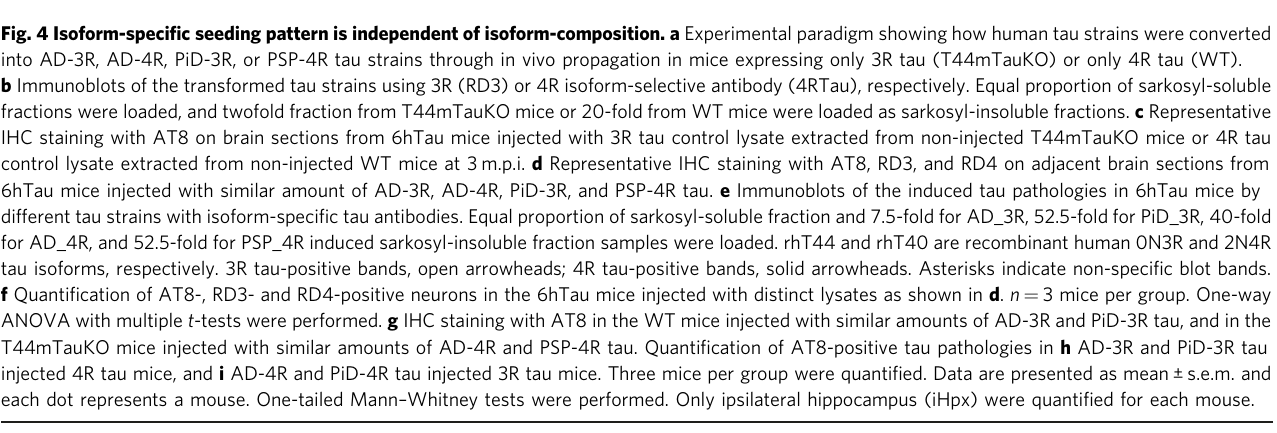
Fig. 4 Isoform-speci fi c seeding pattern is independent of isoform-composition. a Experimental paradigm showing how human tau strains were converted into AD-3R, AD-4R, PiD-3R, or PSP-4R tau strains through in vivo propagation in mice expressing only 3R tau (T44mTauKO) or only 4R tau (WT). b Immunoblots of the transformed tau strains using 3R (RD3) or 4R isoform-selective antibody (4RTau), respectively. Equal proportion of sarkosyl-soluble fractions were loaded, and twofold fraction from T44mTauKO mice or 20-fold from WT mice were loaded as sarkosyl-insoluble fractions. c Representative IHC staining with AT8 on brain sections from 6hTau mice injected with 3R tau control lysate extracted from non-injected T44mTauKO mice or 4R tau control lysate extracted from non-injected WT mice at 3 m.p.i. d Representative IHC staining with AT8, RD3, and RD4 on adjacent brain sections from 6hTau mice injected with similar amount of AD-3R, AD-4R, PiD-3R, and PSP-4R tau. e Immunoblots of the induced tau pathologies in 6hTau mice by different tau strains with isoform-speci fi c tau antibodies. Equal proportion of sarkosyl-soluble fraction and 7.5-fold for AD_3R, 52.5-fold for PiD_3R, 40-fold for AD_4R, and 52.5-fold for PSP_4R induced sarkosyl-insoluble fraction samples were loaded. rhT44 and rhT40 are recombinant human 0N3R and 2N4R tau isoforms, respectively. 3R tau-positive bands, open arrowheads; 4R tau-positive bands, solid arrowheads. Asterisks indicate non-speci fi c blot bands. f Quanti fi cation of AT8-, RD3- and RD4-positive neurons in the 6hTau mice injected with distinct lysates as shown in d . n = 3 mice per group. One-way ANOVA with multiple t -tests were performed. g IHC staining with AT8 in the WT mice injected with similar amounts of AD-3R and PiD-3R tau, and in the T44mTauKO mice injected with similar amounts of AD-4R and PSP-4R tau. Quanti fi cation of AT8-positive tau pathologies in h AD-3R and PiD-3R tau injected 4R tau mice, and i AD-4R and PiD-4R tau injected 3R tau mice. Three mice per group were quanti fi ed. Data are presented as mean ± s.e.m. and each dot represents a mouse. One-tailed Mann – Whitney tests were performed. Only ipsilateral hippocampus (iHpx) were quanti fi ed for